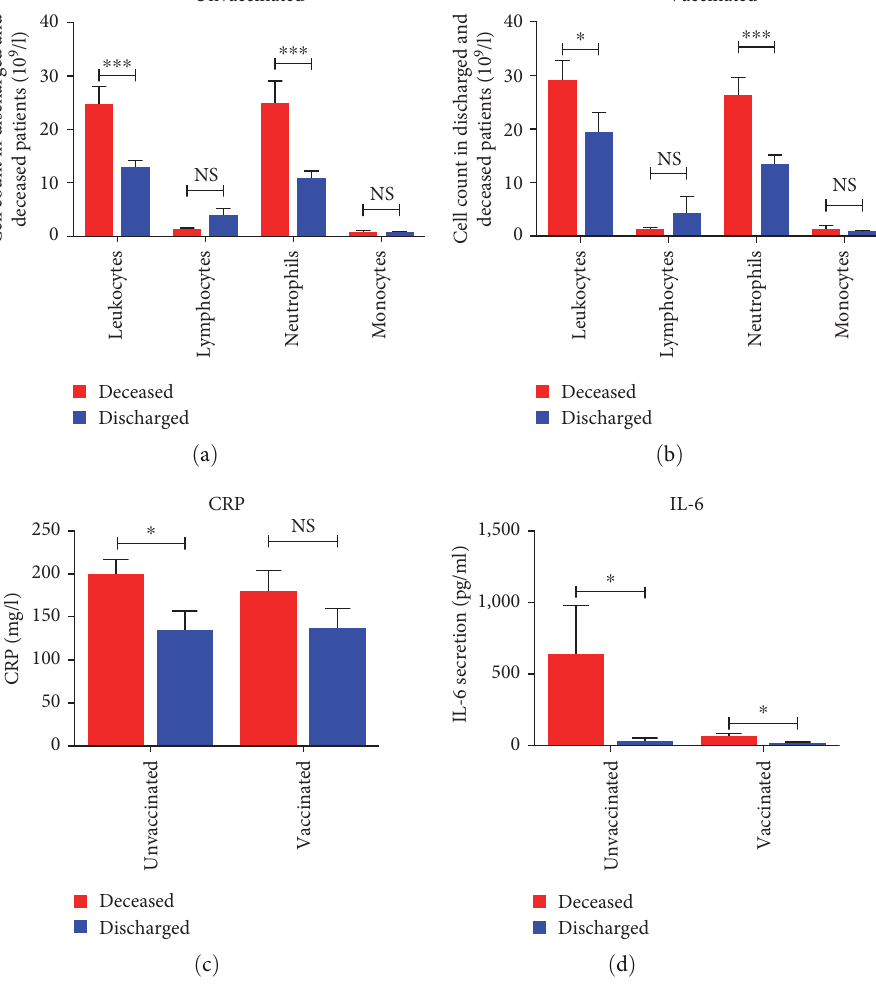
F IGURE 6: Immune response in unvaccinated and vaccinated patients according to their living status. Unvaccinated deceased patients ( n =33), unvaccinated discharged patients ( n =17), vaccinated deceased patients ( n =26), and vaccinated discharged patients ( n =18). NS, no signi fi cant; ∗ p < 0 : 05, ∗∗∗ p < 0 :